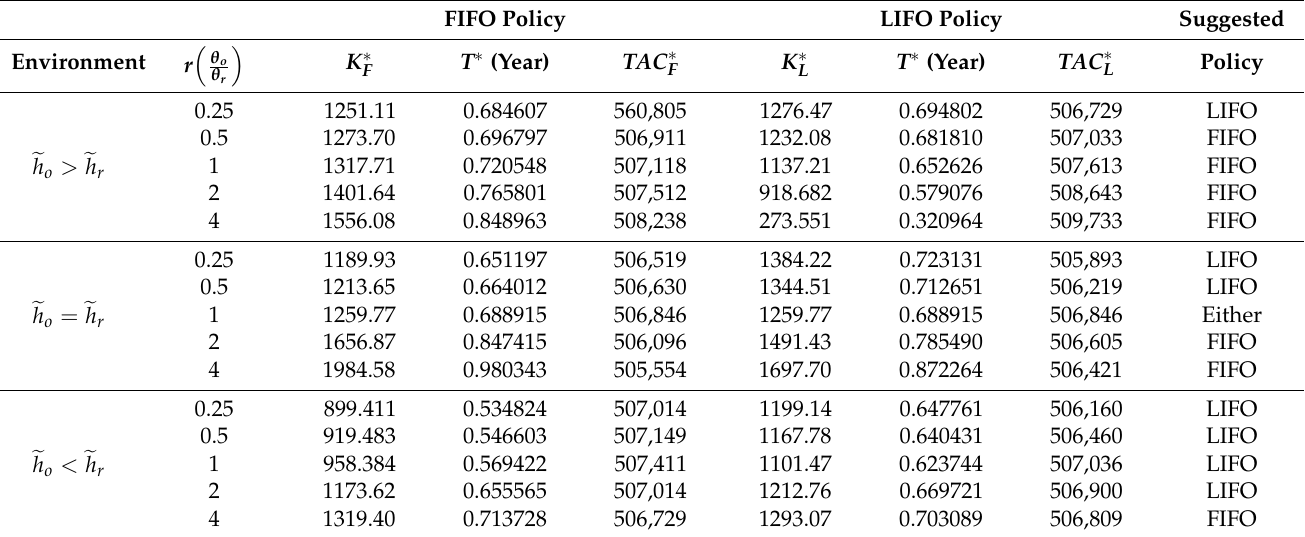
Table 5. Optimal cost of inventory system under various holding costs and deterioration rates. FIFO Policy LIFO Policy